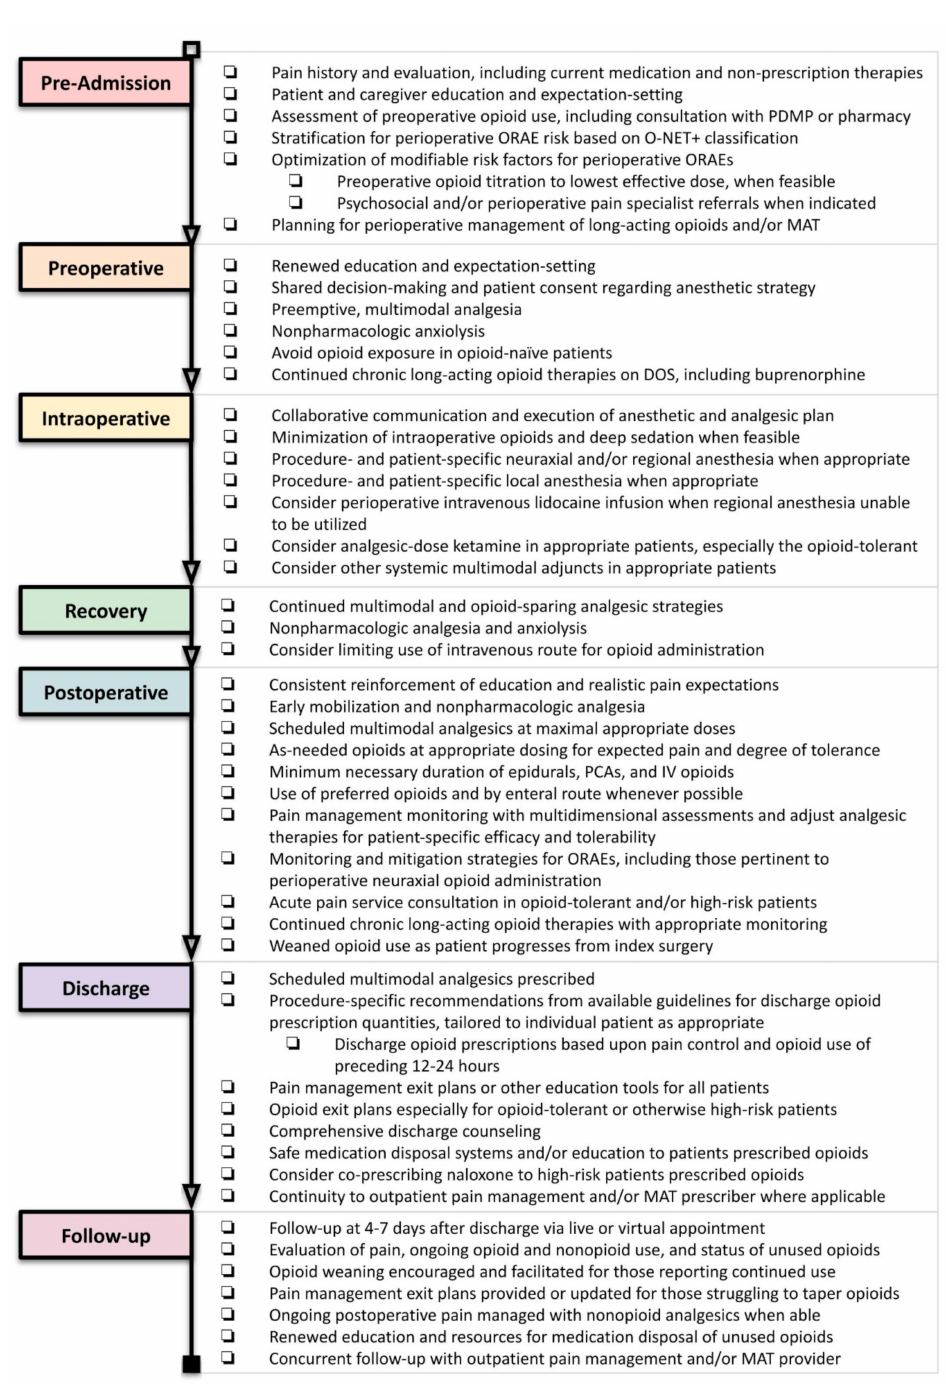
Figure 1. Perioperative Pain Management and Opioid Stewardship Interventions across the Contin- uum of Care. Legend: DOS = day of surgery, IV = intravenous, MAT = medication-assisted treatment (i.e., for substance use disorders), O-NET+ = opioid-naïve, -exposed or -tolerant, plus modifiers classifica- tion system, ORAE = opioid-related adverse event, PCA = patient-controlled (intravenous) analgesia, PDMP = prescription drug monitoring